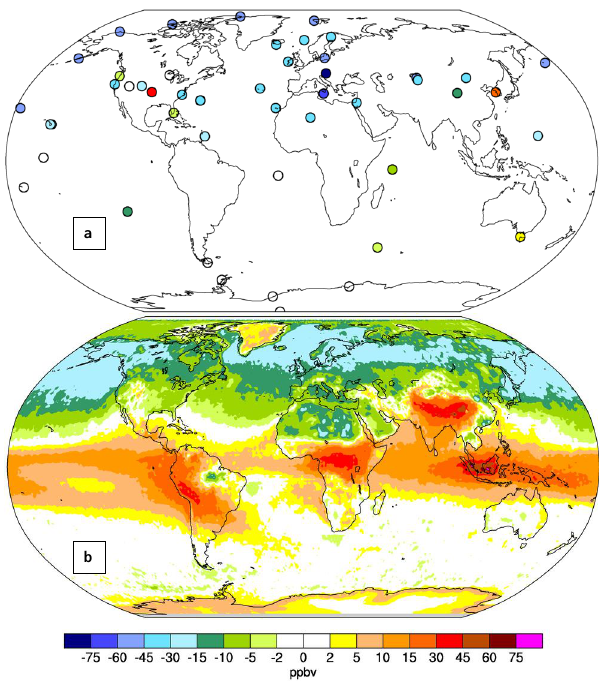
Figure 2. Annual average bias of multi-model mean CO for 2000 against a) surface CO observations averaged over the 1996 to 2005 period from the NOAA Global Monitoring Division (GMD) network (Novelli and Masarie, 2010; downloaded on April 11, 2012) and b) average 2000-2006 MOPITT CO at 500 hPa. Each circle in (a) indicates the annual mean bias at the CO measurement site. For comparison with satellite observations in (b), each model was convolved with the MOPITT operator (a priori and averaging kernels) before taking the difference.